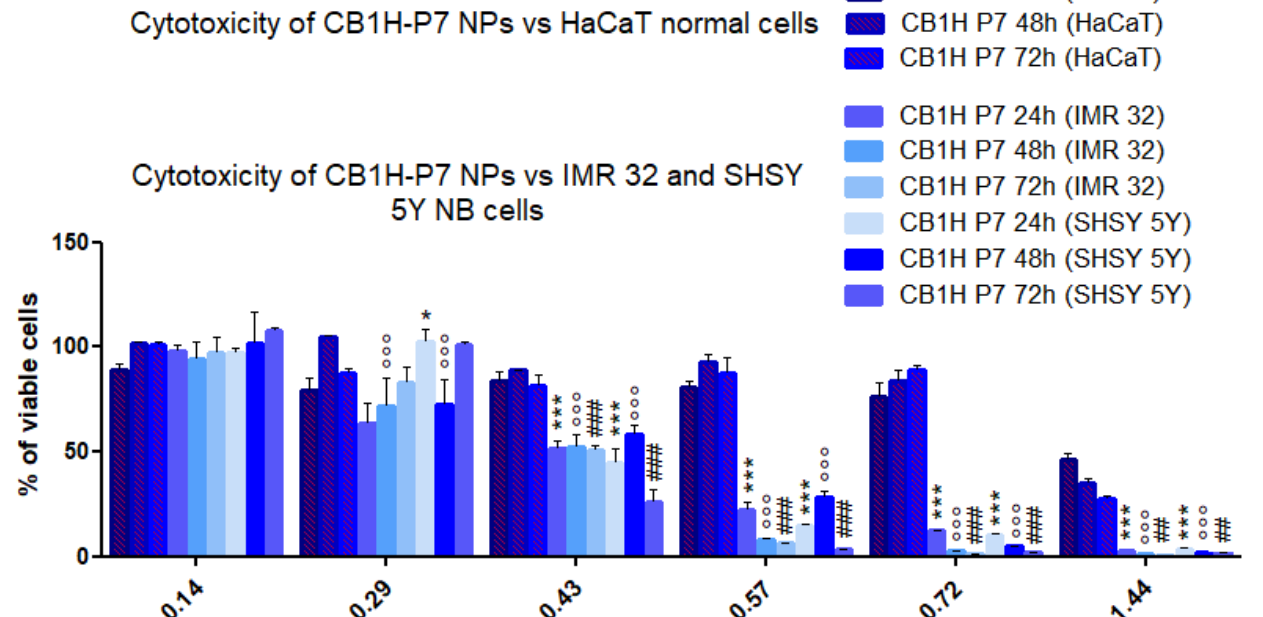
Figure 3. Dose- and time-dependent cytotoxicity activity of CB1H-P7 NPs at 24 h ( a ), 48 h ( b ), and 72 h ( c ) towards HaCaT, IMR 32 and SHSY 5Y cells. Significance refers to HaCaT cells at 24 h (*), 48 h (°), or 72 h (#). Specifically, p > 0.05 ns; p < 0.05 * (24h), ° (48h), # (72h); p < 0.01 ** (24h), °° (48h), ## (72h); p < 0.001 *** (24h), °°° (48h), ### (72h).